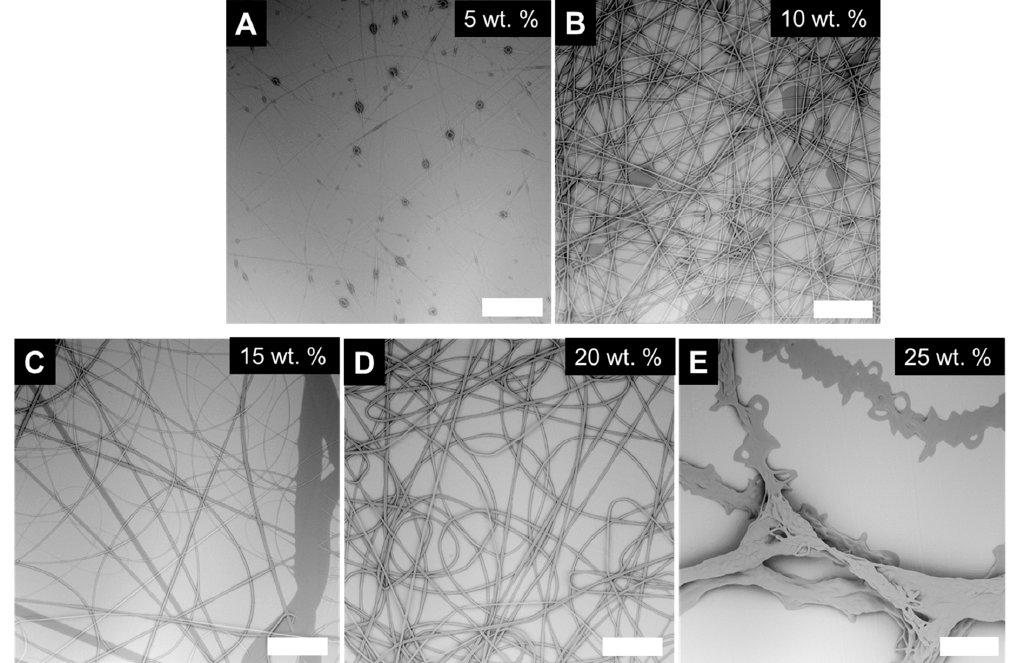
Figure 4. SEM micrographs of polyvinylpyrrolidone (PVP) electrospun from increasing concentrations in ethanol. ( A ) Low concentrations (5 wt.% PVP) produced bead on a string morphologies, ( B ) 10 wt.% produced beaded fibers, ( C ) 15 wt.%, and ( D ) 20 wt.% produced relatively